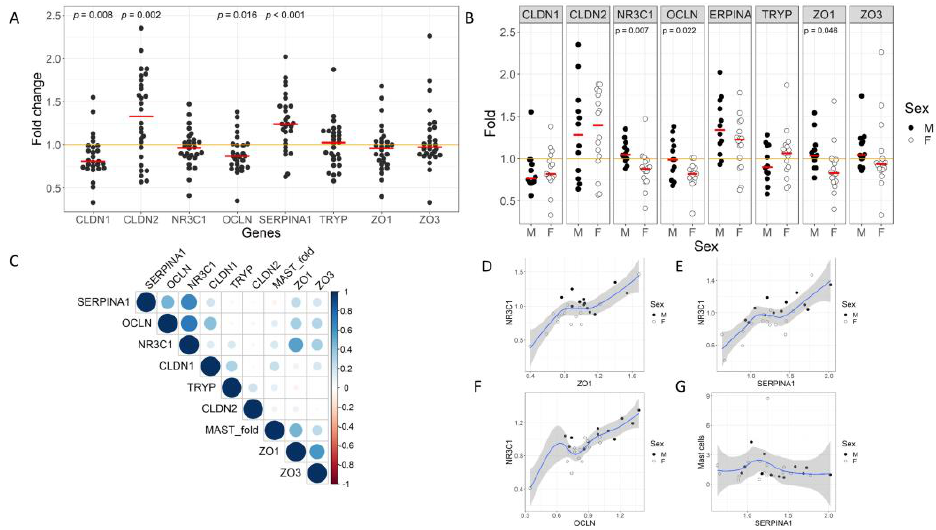
Figure 5. Gene expression levels of CLDN1, CLDN2, NR3C1, OCLN, SERPINA1, ZO-1, ZO-3 , and TRYP in jejunal mucosa after CPS. ( A ) Fold change of gene expression levels induced by stress in jejunal mucosa. The red line indicates the median. ( B ) Fold change of gene expression levels induced by stress in jejunal mucosa by sex. The red line indicates the median. ( C ) Correlation graph with hierarchical clustering of the fold change in the gene expression levels and the number of MCs induced by stress. The dots size and color of the dots represent the degree of correlation (Spearman’s rho). ( C – G ) represent the correlation distribution of the fold change expression levels induced by stress among NR3C1, ZO-1, SERPINA1 , and MC cell numbers. The blue line indicates the Loess regression and the gray area the confidence interval of 95%. Males and females are represented with back circles and white circles, respectively. F: females; M: males; CLDN1: claudin 1; CLDN2 : claudin 2; OCLN : occludin; ZO-1 : zonula occludens 1; ZO-3 : zonula occludens 3; TRYP : tryptase; SERPINA1 : serpin family A member 1; NR3C1 : glucocorticoid receptor nuclear receptor subfamily 3 group C member 1.